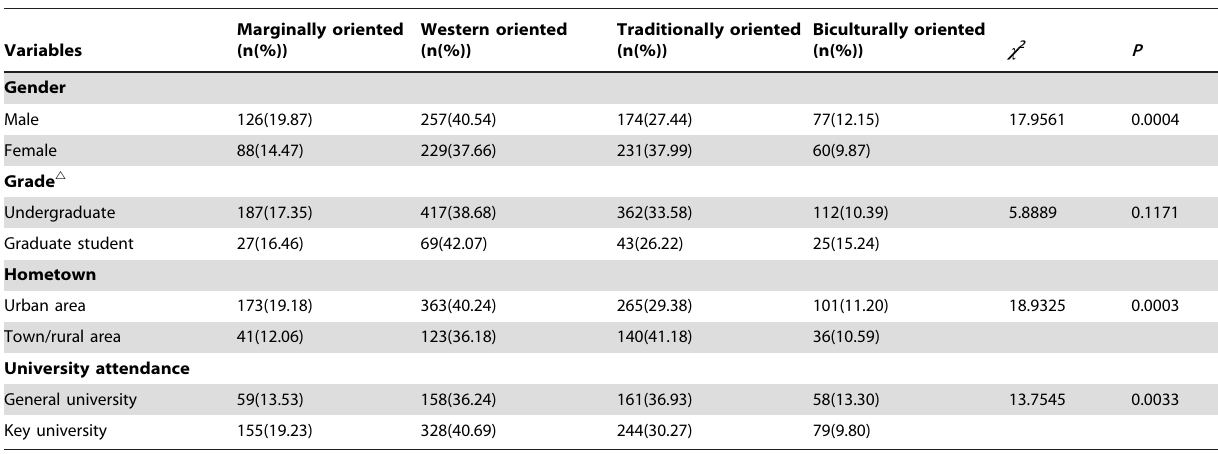
Table 2. Demographic difference in cultural orientation (N =1242).